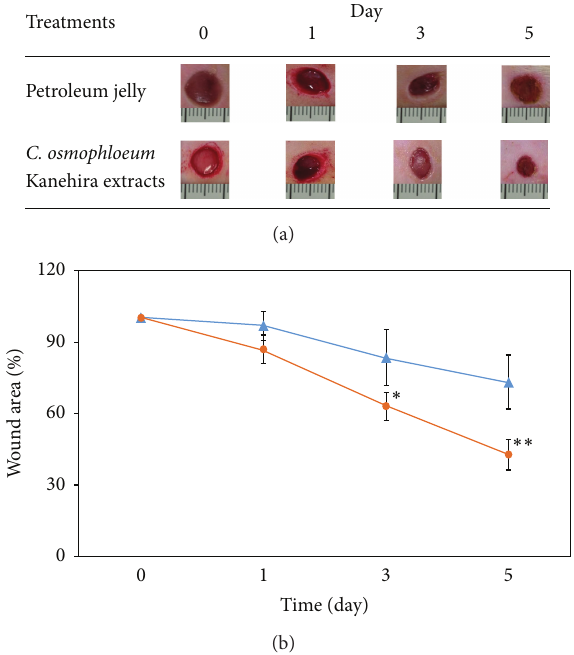
Figure 5: The wound healing of C. osmophloeum extracts on animal model. (a) Wound healing after 0, 1, 3, and 5 days after injury. After the full thickness excisions of 1cm in diameter were made, the petroleum jelly (8% DMSO, w/v) or 0.8 mg C. osmophloeum extracts covered on the hurt. For injury group, wounds were not covered for control. At the first day, the wound healing area from petroleum jelly (8% DMSO) group was smaller than that of C. osmophloeum group until 5 days. (b) The differences between wounds of petroleum jelly (8% DMSO, w/v, blue solid triangle) and 0.8mg C. osmophloeum group (orange solid circle) were statistically significant at day 5. Data: the mean value ± SD (triplicate values in two independent experiments); ∗ < 0.01 , ∗∗ < 0.001